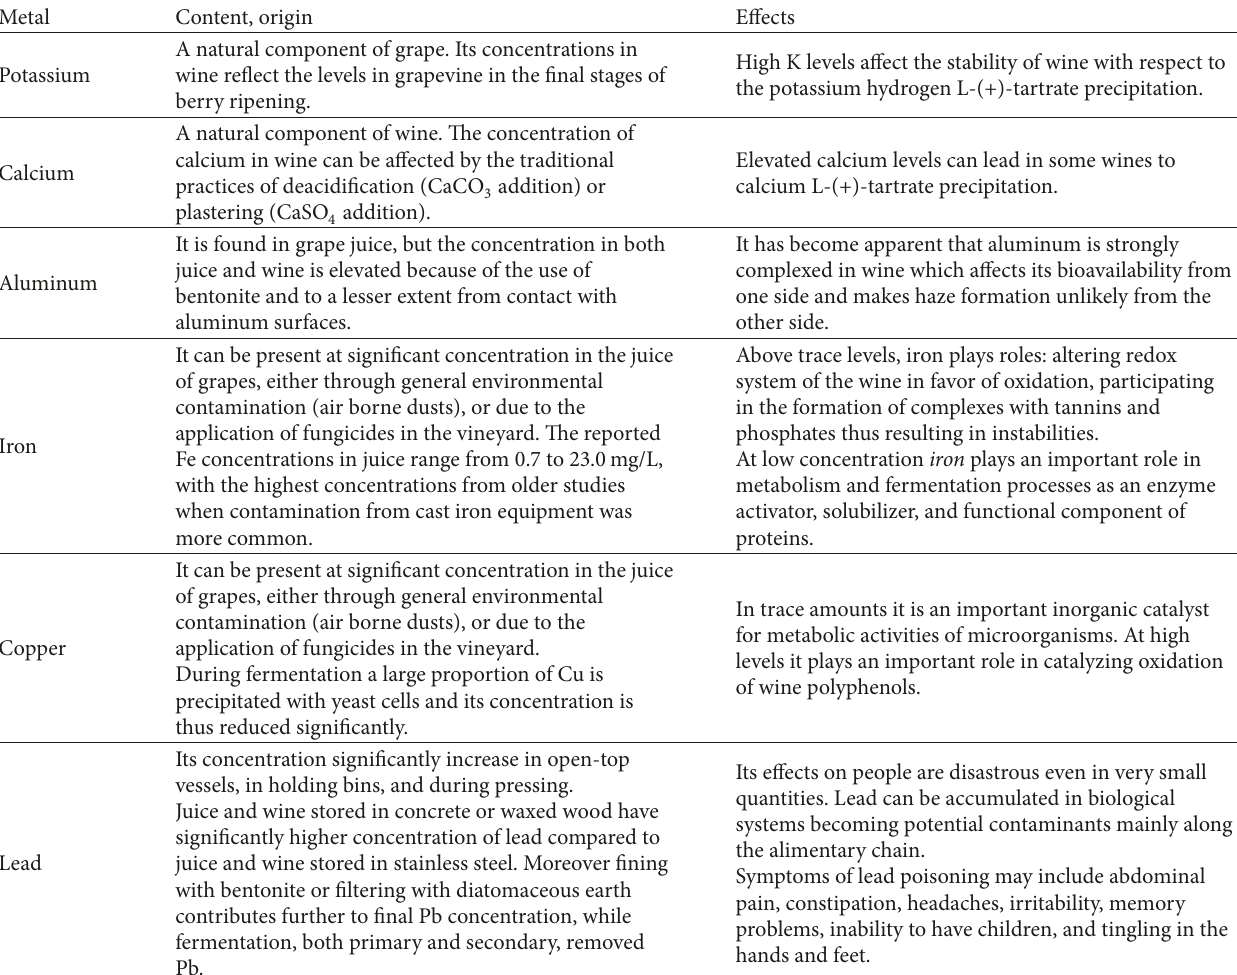
Table 1: Information on metals mainly occurring in wine